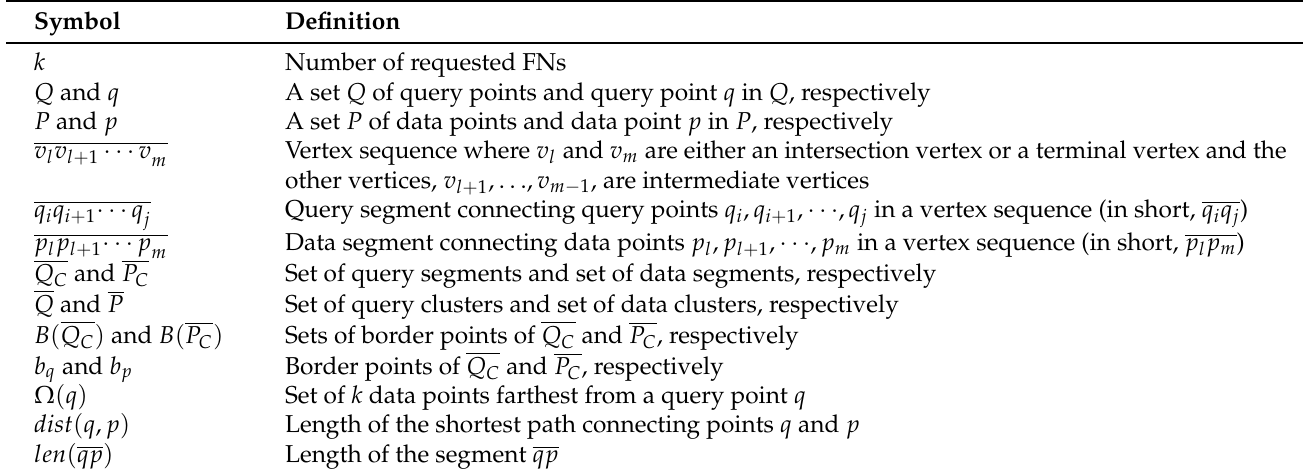
Table 2. Symbols used in this paper and their